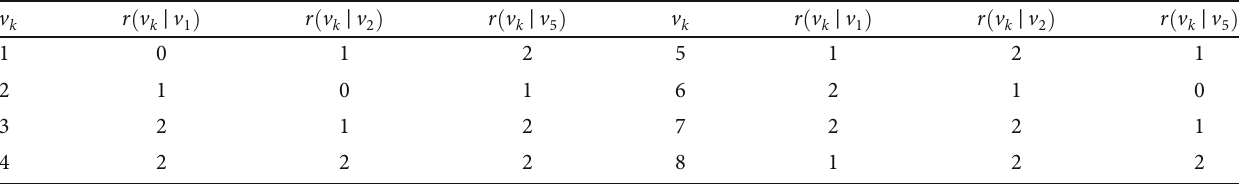
g = f v , v , v 1 2 5 a